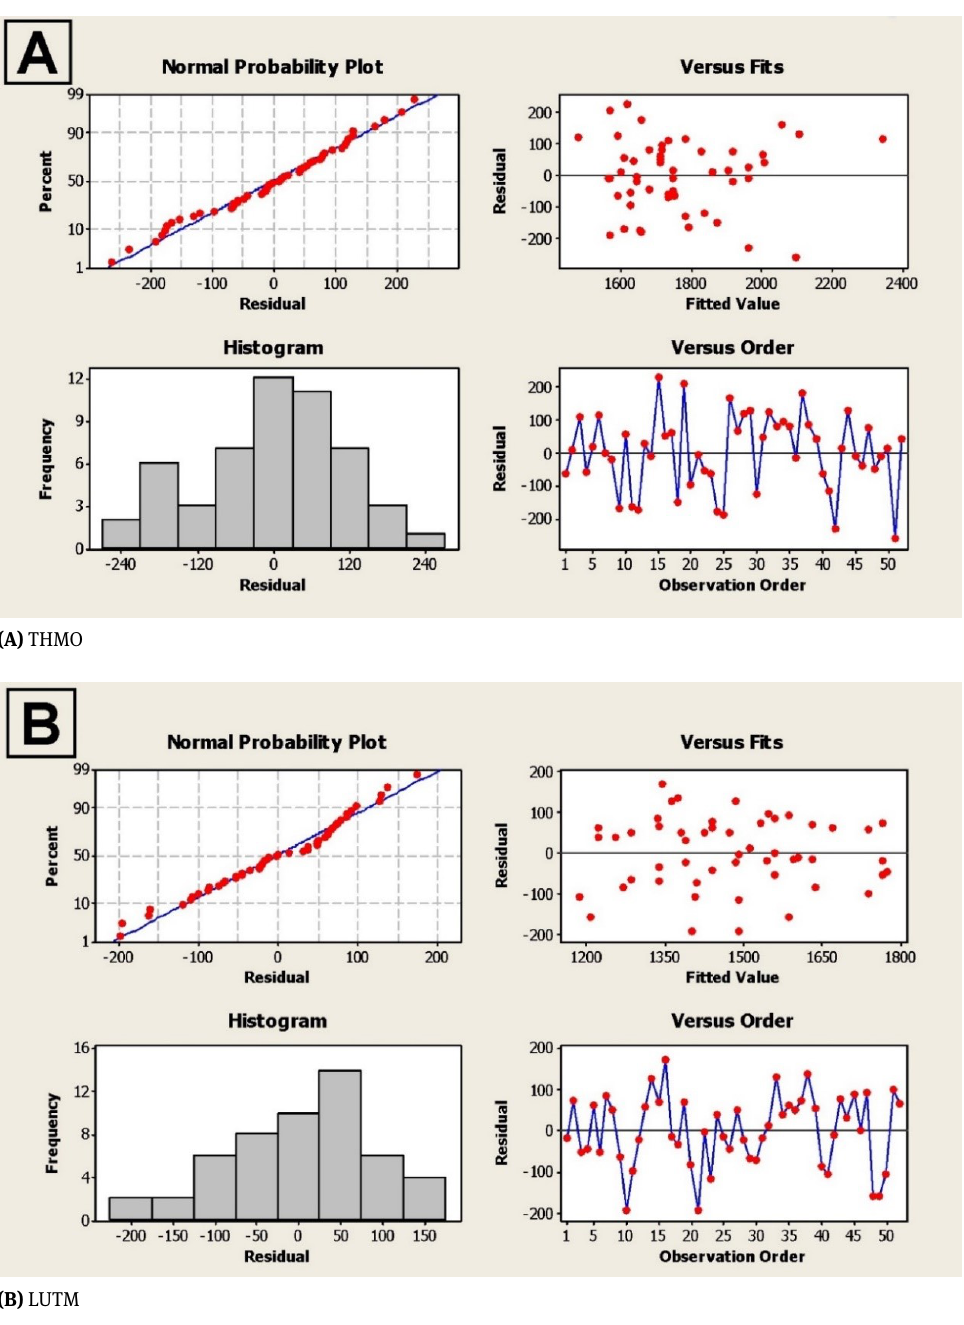
Figure 3: Minitab Output Residual